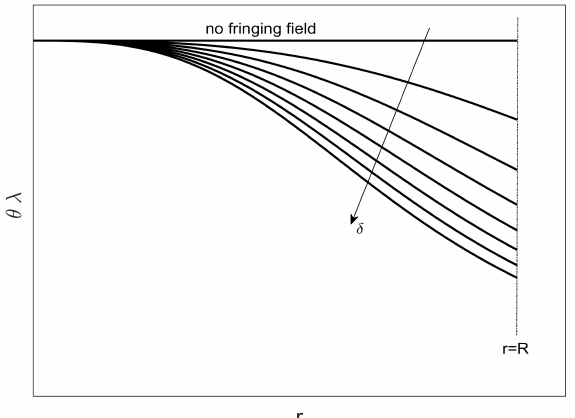
Figure 2. θλ versus r : under each curve, as δ increases, there is a forbidden